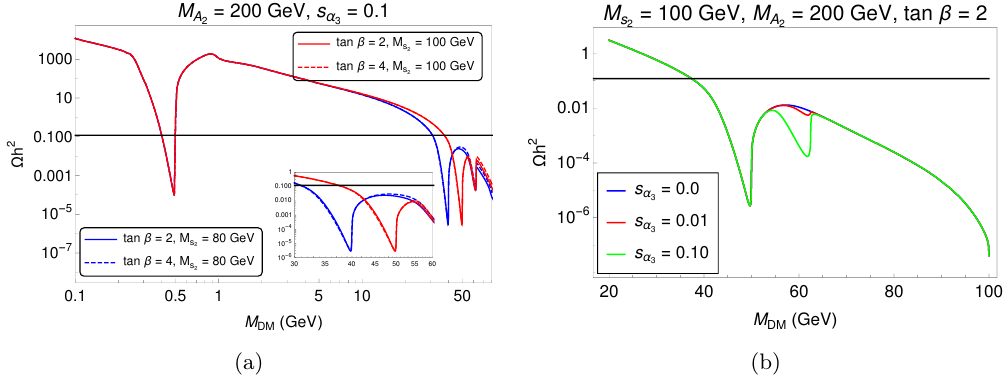
Figure 19 . (a) The variation of relic abundance with the dark matter mass for different values of tan β and the mass M s . In the inset we have zoomed into the annihilation peaks of the DM for 2 30 < M DM ( GeV ) < 60 . The black solid line denotes the Planck observed relic of DM. (b) Same as in figure 19(a) for different values of sine of the mixing angle α 3 .